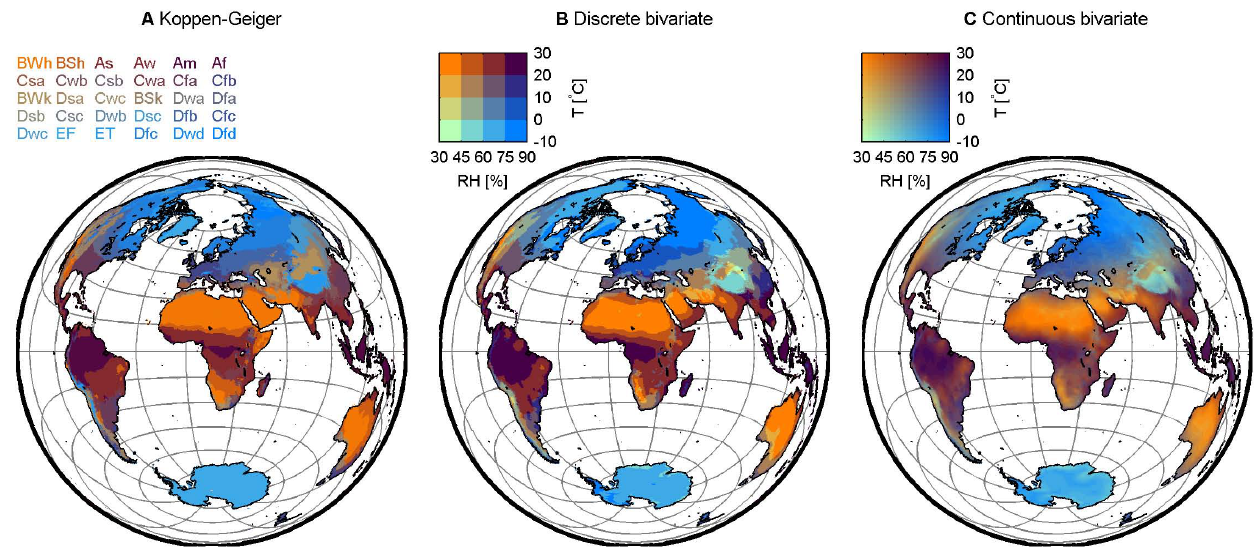
Fig. 2. Global distribution of climate zones. (A) : K¨oppen-Geiger classification. Colouring is taken from Fig. 1. Data are taken from Kottek et al. (2006). (B) : Discrete (4 × 4) bivariate classification of climate based on expected values of T and RH. (C) : (Near-)continuous (16 × 16) bivariate classification. Note the correspondence between (A) and (B) . Data in (A) and (B) are gridded observations (10 min spatial resolution resampled to 0.5 degree resolution) for the period 1961–1990 compiled by the Climate Research Unit (e.g. New et al., 2002; Mitchell and Jones, 2005) extended with ERA-40 reanalysis over the Antarctic.